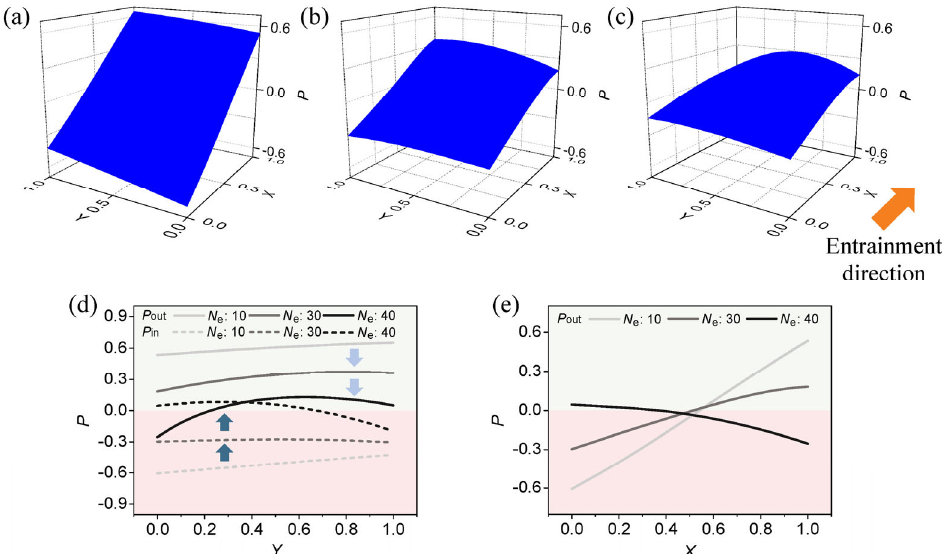
Fig. 3 Calculated pressure distributions for various N e inside the lubrication domain: (a) N e = 10, (b) N e = 30, (c) N e = 40 and at boundaries, (d) the inlet and outlet, and (e) side